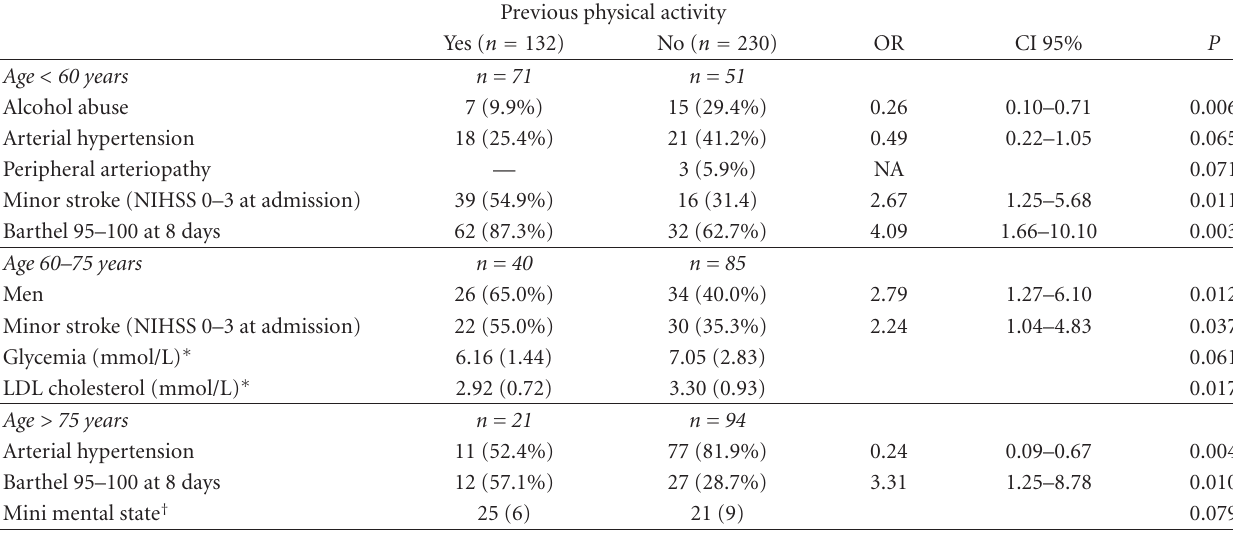
Figure 1: Impact of previous leisure-time physical activity on initial stroke severity. Table 2: Main characteristics associated to previous leisure-time physical activity according to